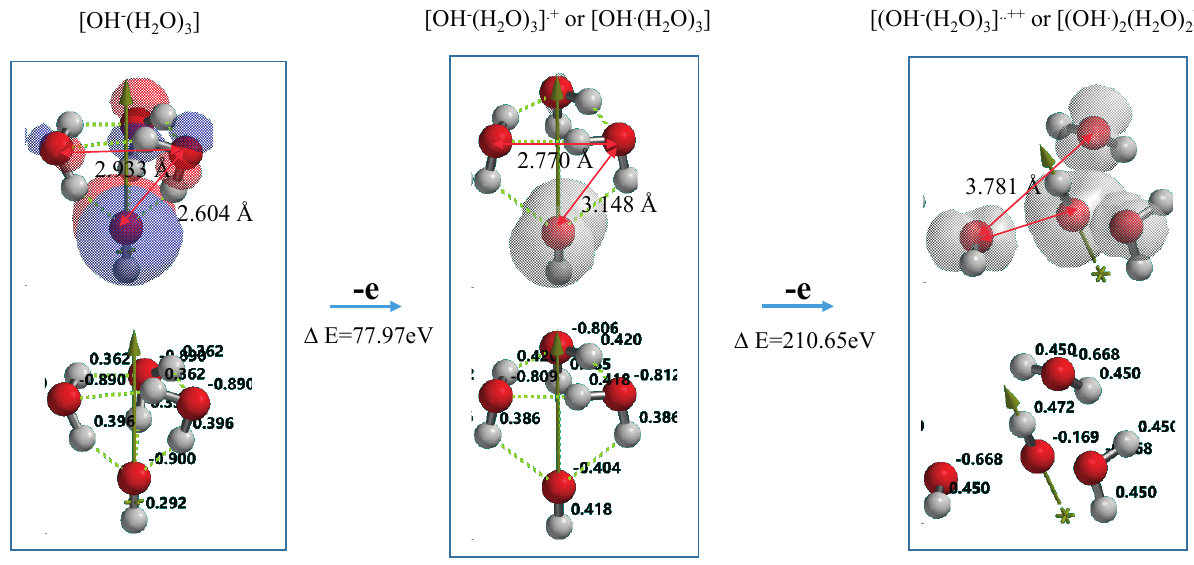
Figure 7. DFT-simulation of step-wise oxidation of the hydroxide ion cluster model of [OH − (H 2 O) 3